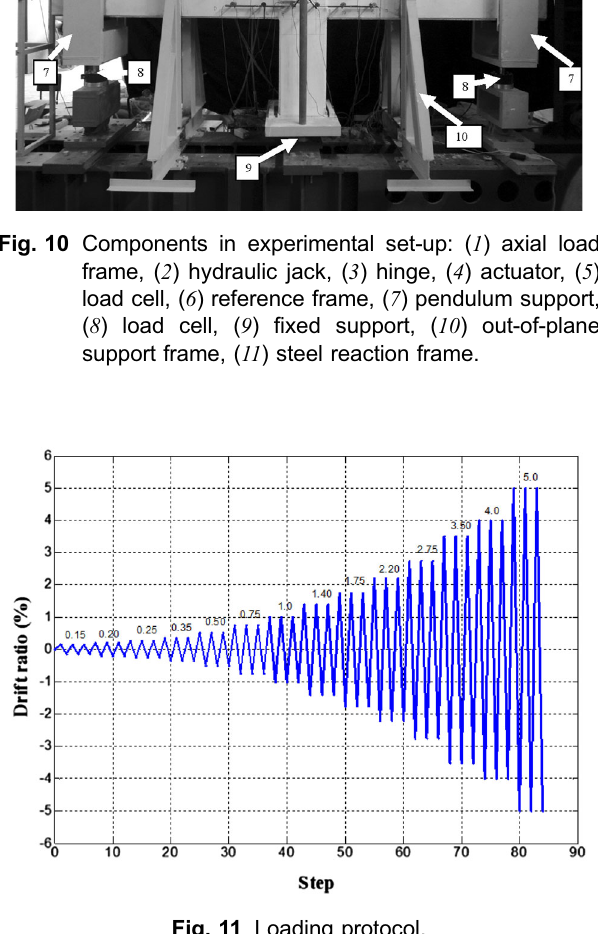
Fig. 11 Loading applied top displacements. Strain gauges were mounted on beam and column longitudinal and transverse rebars to monitor strains throughout the tests as shown in Fig. 13.